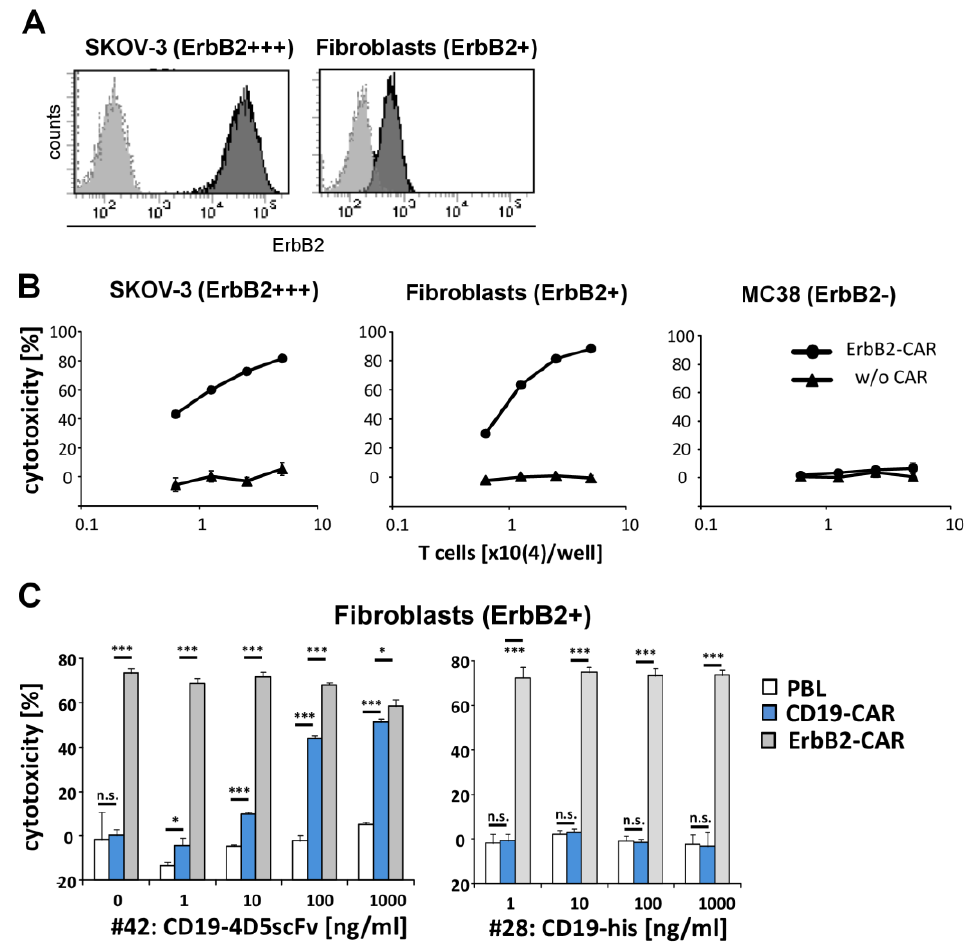
Figure 4. CD19-4D5scFv redirected CD19-CAR T cells discriminate between healthy ErbB2 low fibroblasts and the ErbB2 high SKOV-3 cancer cells while the 4D5scFv-CAR T cells do not. ( A ) Binding of the 4D5scFv to SKOV-3 cancer cells and healthy fibroblasts. Cells were incubated with 100 ng/mL of the 4D5scFv-Fc fusion protein or human IgG1 for the control, for 30 min at 4 ◦ C. Bound antibodies were detected by an anti-human IgG-PE antibody, analyzed by flow cytometry and histograms were overlayed. ( B ) Killing of the SKOV-3 cancer cells and healthy fibroblasts by the anti-ErbB2 CAR T cells. The T cells were engineered with ErbB2-CAR and co-incubated (0.625–5 × 10 4 cells/well) for 48 h with human SKOV-3 cells, healthy human fibroblasts, and murine ErbB2-MC38 cancer cells (each 2 × 10 4 cells/well), respectively. Non-transduced T cells served as controls. Viability was determined by the XTT assay and the specific lysis was calculated. Values represent the mean of the technical replicates ± SD. ( C ) Different killing of the healthy fibroblasts by the CD19-4D5scFv redirected CD19-CAR T cells and the ErbB2-CAR T cells. The T cells were engineered with anti-CD19 and anti-ErbB2 CARs, respectively, and co-incubated (2 × 10 4 cells/well) for 18 h with human fibroblasts (2 × 10 4 cells/well), in the presence of serial dilutions (1–1000 ng/mL) of CD19-4D5scFv (#42) and CD19-his (#28) fusion protein, respectively. For the controls, non-transduced T cells and CD19 fusion protein without ErbB2 binding domain were used. Viability was determined by the XTT assay and the specific cytotoxicity was calculated. Values represent the mean of the technical replicates ± SD. Significant differences were determined by Student’s t test: *** p < 0.001; * p < 0.05; n.s. = not significant. We addressed whether the CD19-CAR T cells can be redirected against the estab- lished ErbB2 + solid tumors in vivo, by adding the CD19-4D5scFv engager protein. To address this issue we grafted Rag2 −/− c γ −/− mice (5 mice/group) subcutaneously with the SKOV-3 cancer cells. The mice with established tumors (tumor size >50 mm 3 ) were